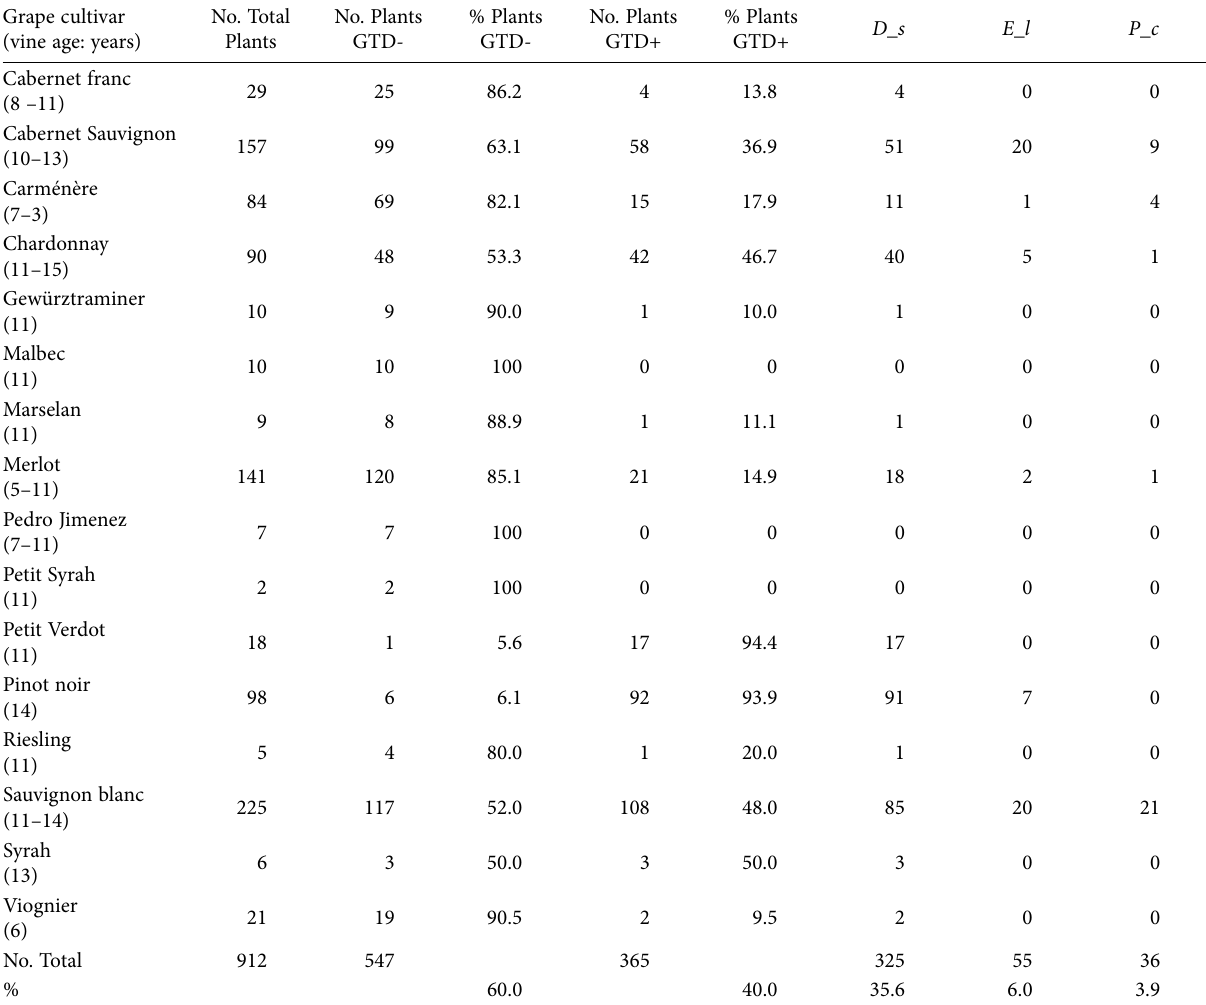
Table 4. Incidence of GTDs by grape cultivar. No. = number, GTD- = plants with no GTD fungi, GTD+ = plants with GTD fungi. D_s = Diplodia seriata , E_l = Eutypa lata and P_c = Phaeomoniella chlamydospora . The numbers below each fungus are the number of positive plants for that